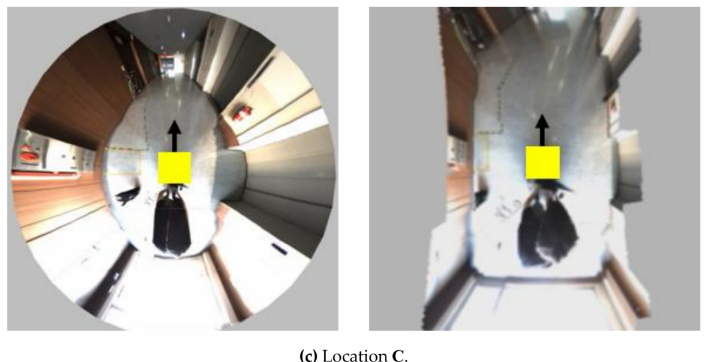
Figure 15. Comparison of the experimental results between the existing WAVM (left) [10] and the proposed system (right) at locations ( A–C ) in Figure 14.